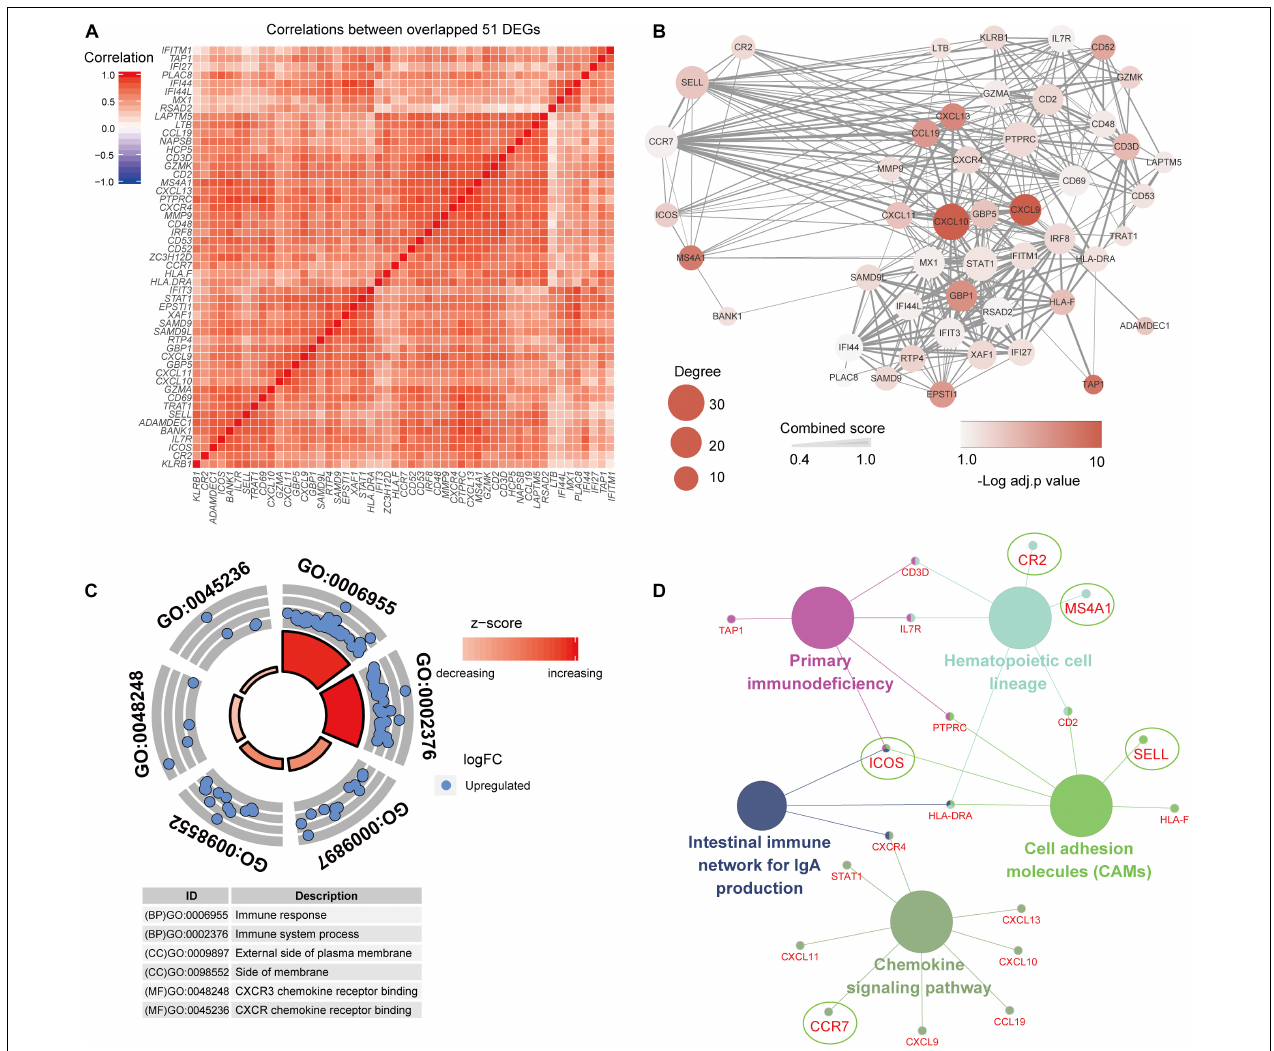
FIGURE 4 | Functional enrichment analysis of 51 common differentially expressed genes (DEGs). (A) The common DEGs show strong associations with each other. (B) The PPI network shows a close interaction of DEGs, and hub genes indicate important roles in the network. (C,D) Gene Ontology and Kyoto Encyclopedia of Genes and Genomes pathway analyses of the common